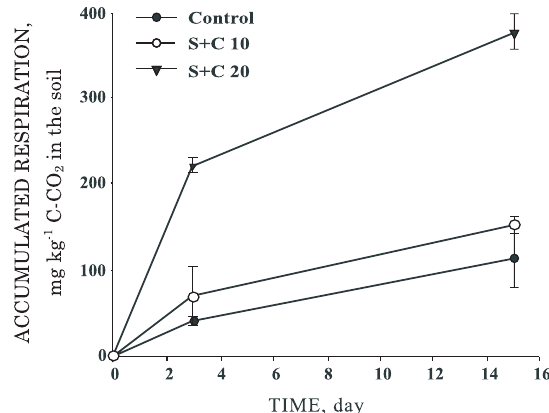
Figure 1. C-CO released after compost application 2 to a Acrustox after 15 days of incubation. Control: without compost amendment; S+C 10: soil with 10 g kg -1 of dry compost in soil; S+C 20: soil with 20 g kg -1 of dry compost in soil. Vertical bars indicate confidence intervals of 5 %